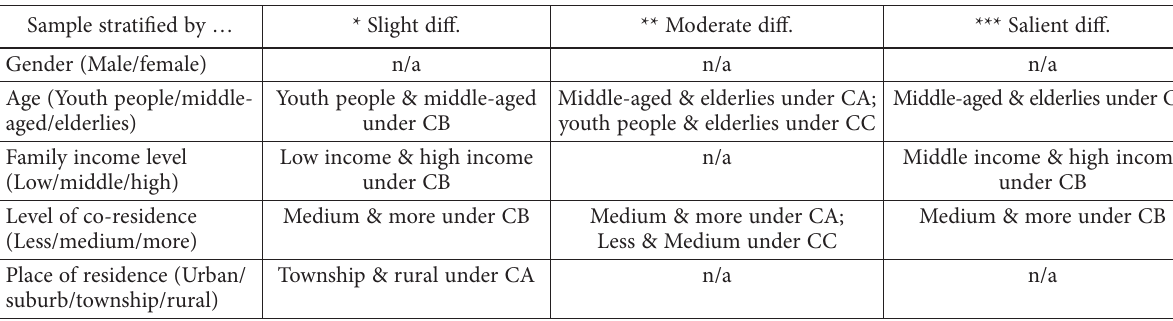
Table 10. A summary of between-group